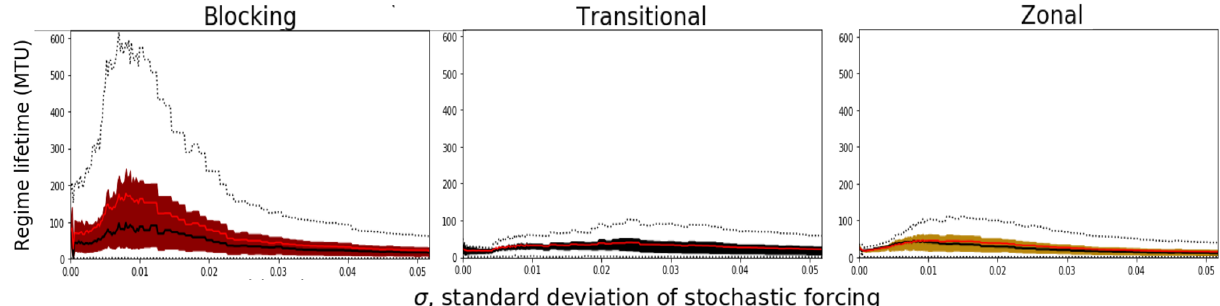
Figure 5. (a) The power spectral density of the total mode amplitude, spectral power averaged over frequencies from 1 / 500 to 1 / 10000MTU − 1 (corresponding to the shaded region of panel a ) as a function of σ .